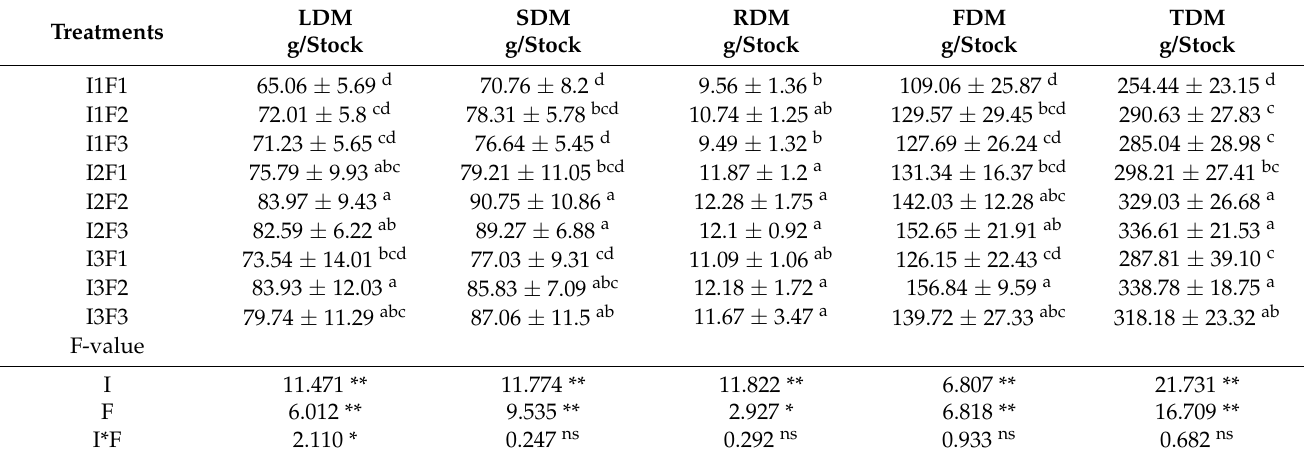
Table 4. Effect of integrated water and fertilizer on the dry matter mass of tomato by moistube irrigation in